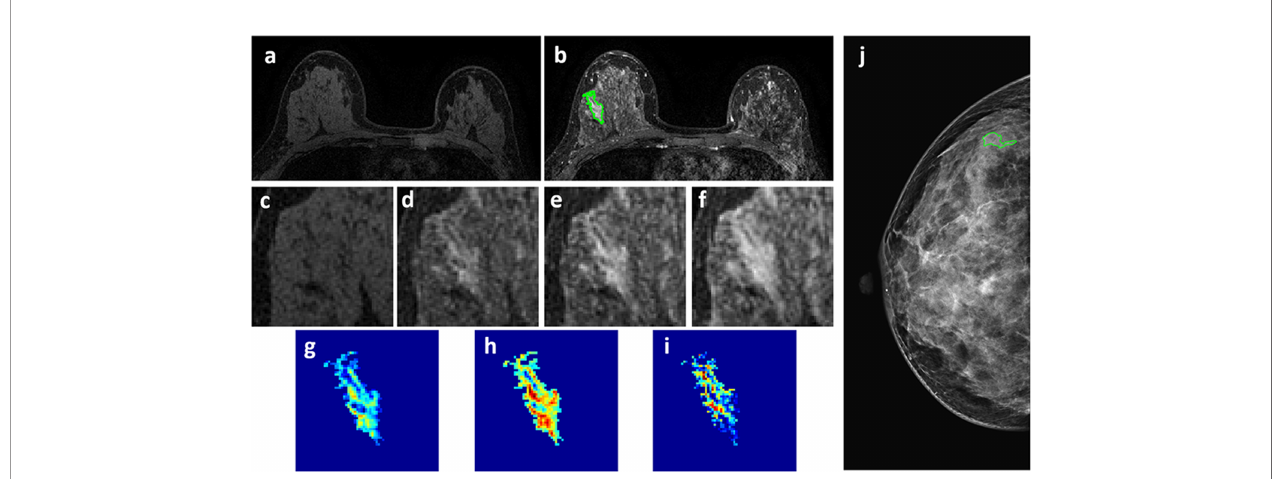
FIGURE 5 | A 46-year-old patient with a 2.7 x 1.3 cm benign adenosis. This is a young woman with extremely dense breasts showing substantial parenchymal enhancements. The lesion shows a persistent DCE-MRI pattern and determined as BI-RADS 4A on MRI. (A) F1 Pre-contrast image. (B) F2 post-contrast image. (C – I) Magni fi ed images to demonstrate the margin and internal enhancements within the lesion. (C) F1 pre-contrast, (D) F2 post-contrast, (E) F3 post-contrast, (F) The last F6 post-contrast image. (G) The wash-in signal enhancement map F2-F1, (H) The F3-F1 signal enhancement map, (I) The wash-out F6-F3 map. (J)